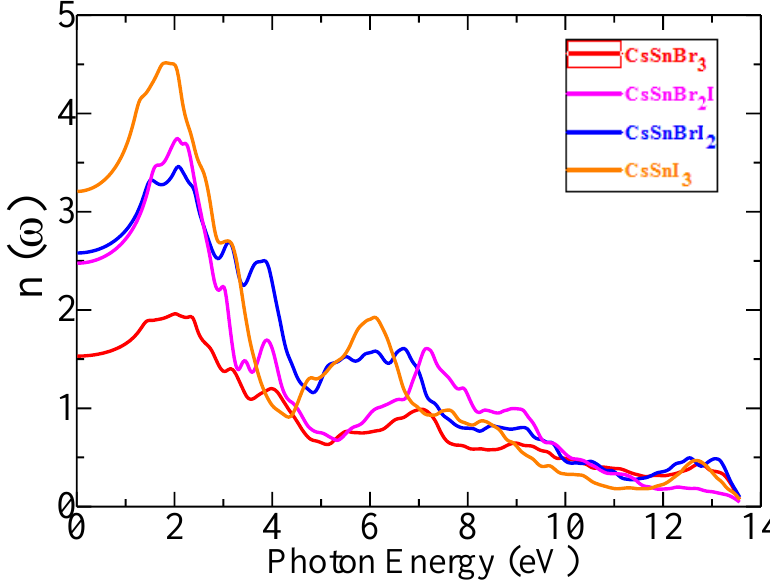
Figure 7. Calculated n(ω) of perovskites of the CsSnBr 3-x I x system depending on the photon